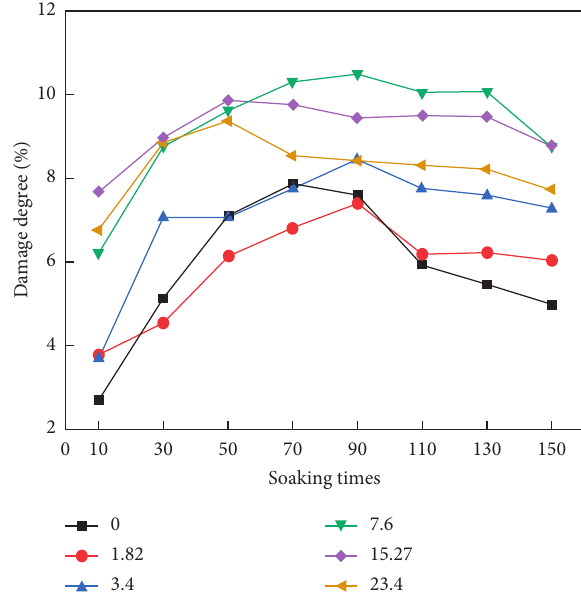
Figure 7: Basalt fiber concrete resistance to sulfate corrosion.